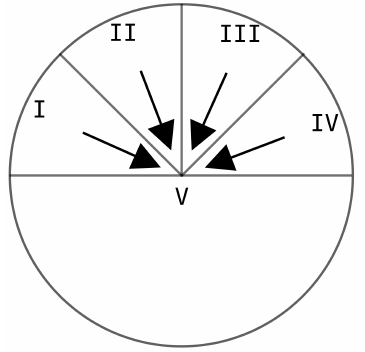
Figure 3. Schematic sketch of wave rose with the five different wave sectors. Sector V represents seaward-directed waves and therefore time periods without morphological changes. The horizontal and vertical line represent the mean coastline and the shore-normal, respectively.